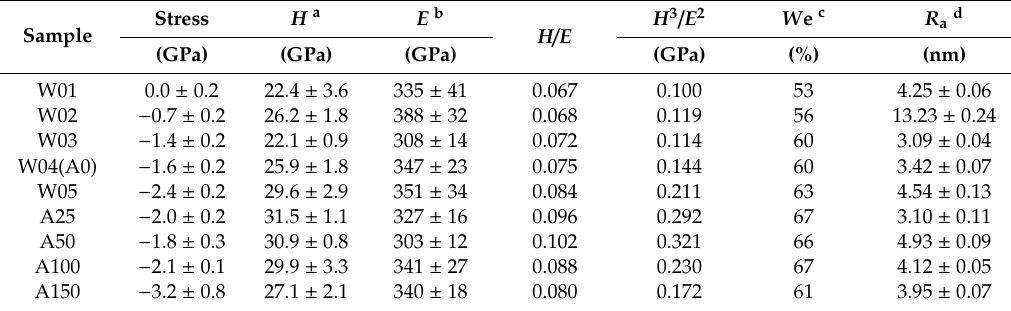
Table 3. Mechanical properties of W–N films.